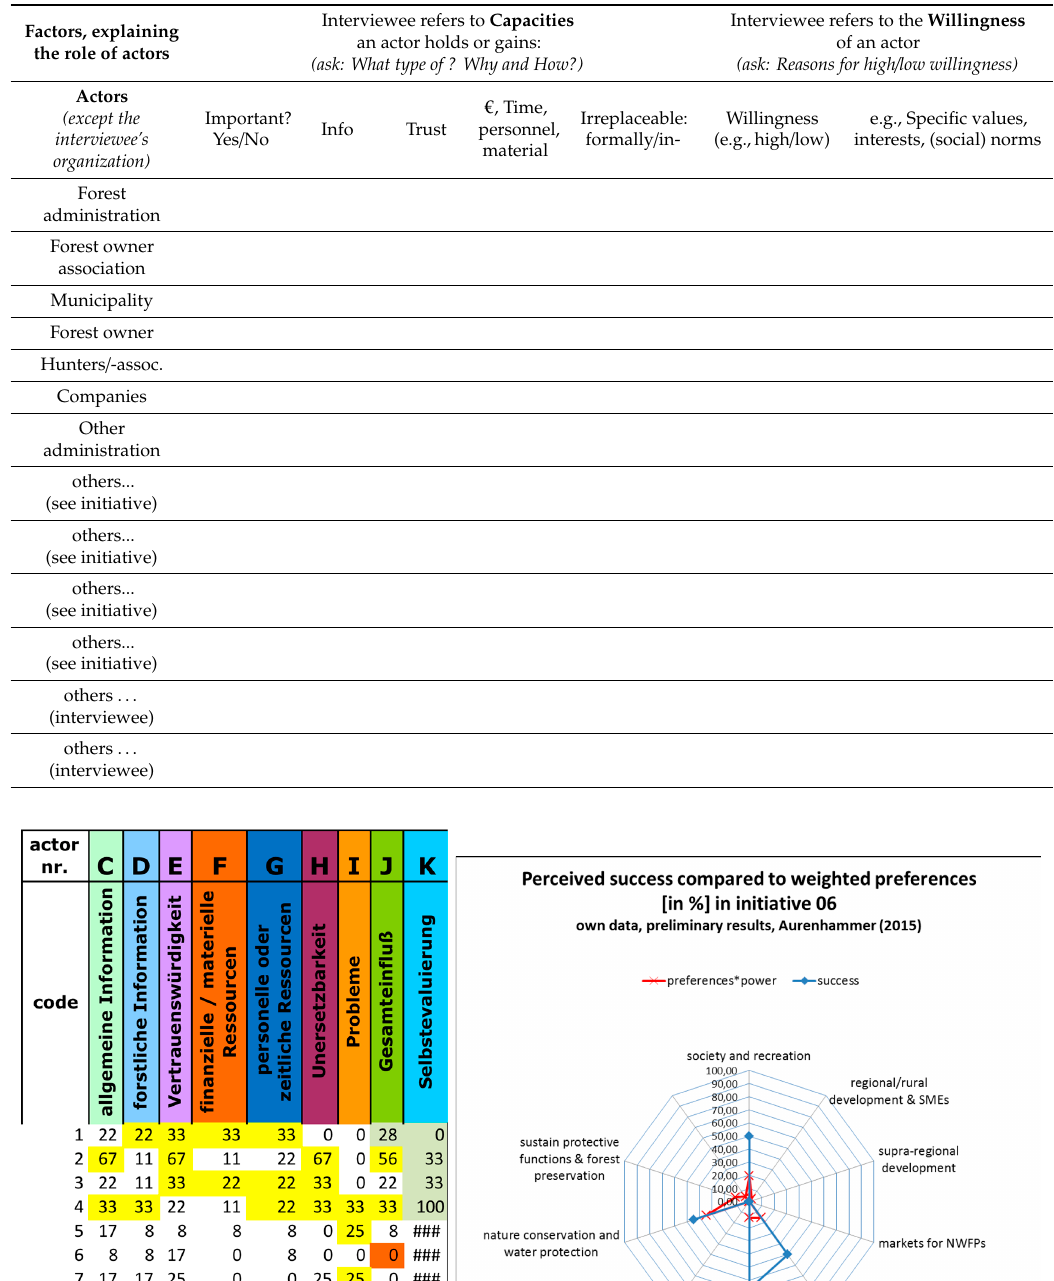
Table A1. Initiative-specific attachments (here standardized).